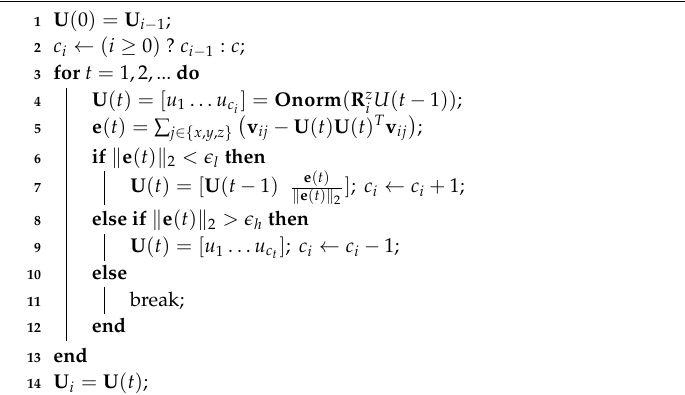
Algorithm 2: Dynamic Orthogonal Iterations applied in the i th